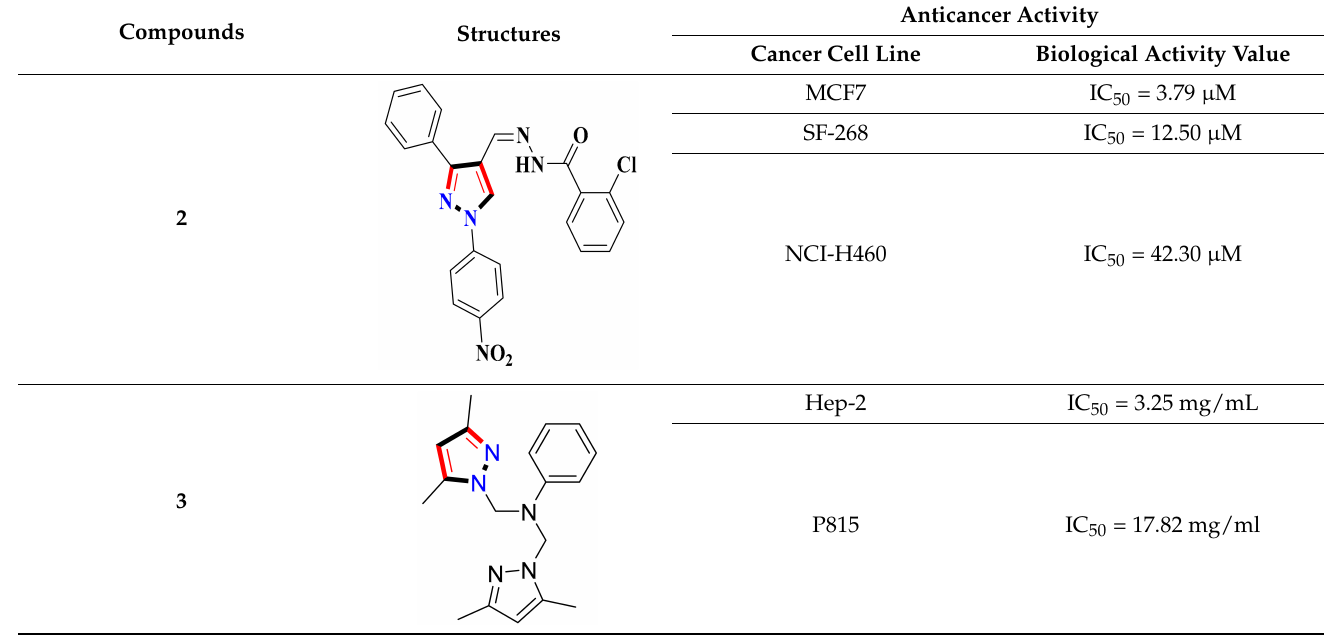
Table 2. Representative compound structures 2 to 18 and their anticancer